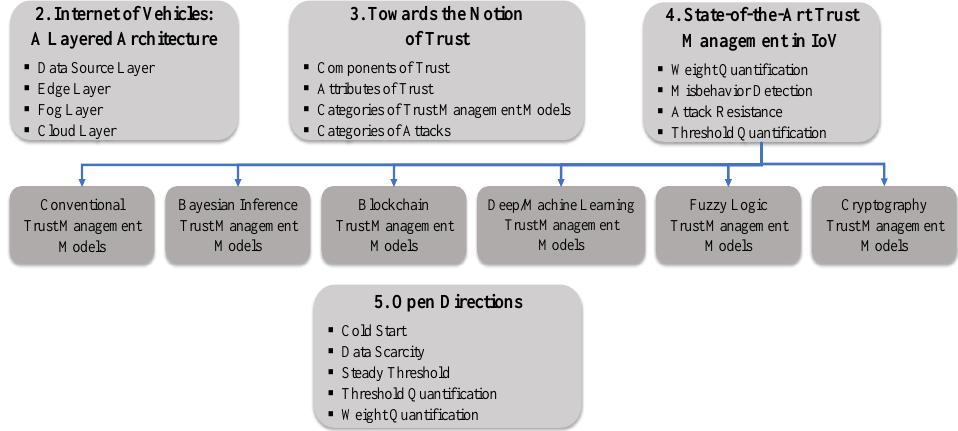
Figure 2. Taxonomy of this